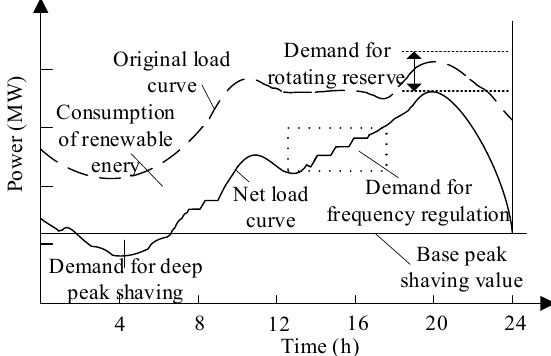
Figure 1. Schematic diagram of regulating demand of power systems.